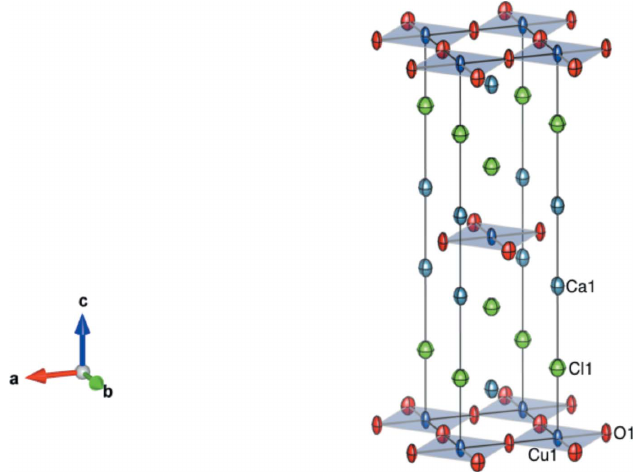
Figure 1 The crystal structure of Ca 2 CuO 2 Cl 2 , showing displacement ellipsoids drawn at the 90% probability